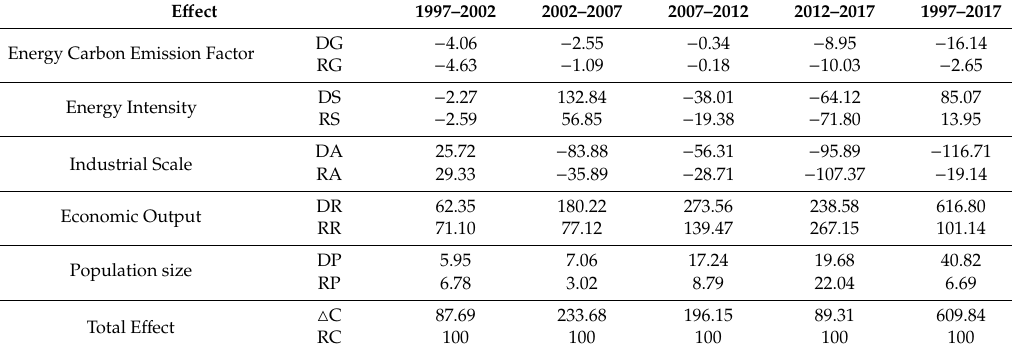
Table 3. Decomposed contribution value (unit: million tons) and contribution rate (unit: %) of influencing factors on carbon emissions of Chinese